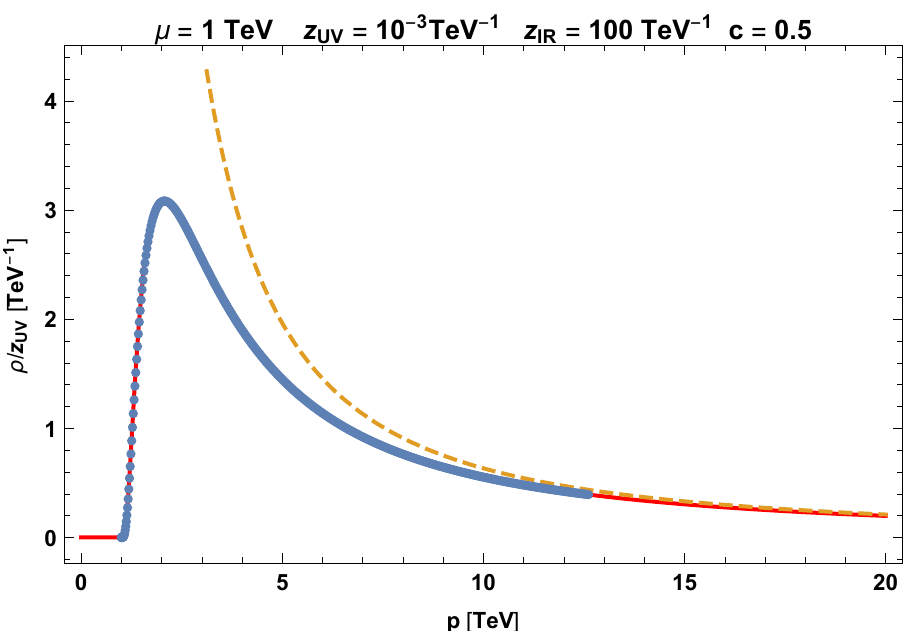
Figure 19. Blue dots are calculated from the KK picture in (B.5). The red curve is the continuum spectral function given by Im (cid:6) F . The yellow dashed line is an approximation to the spectral function valid only when (cid:22) (cid:28) p (cid:28) 1 =z UV